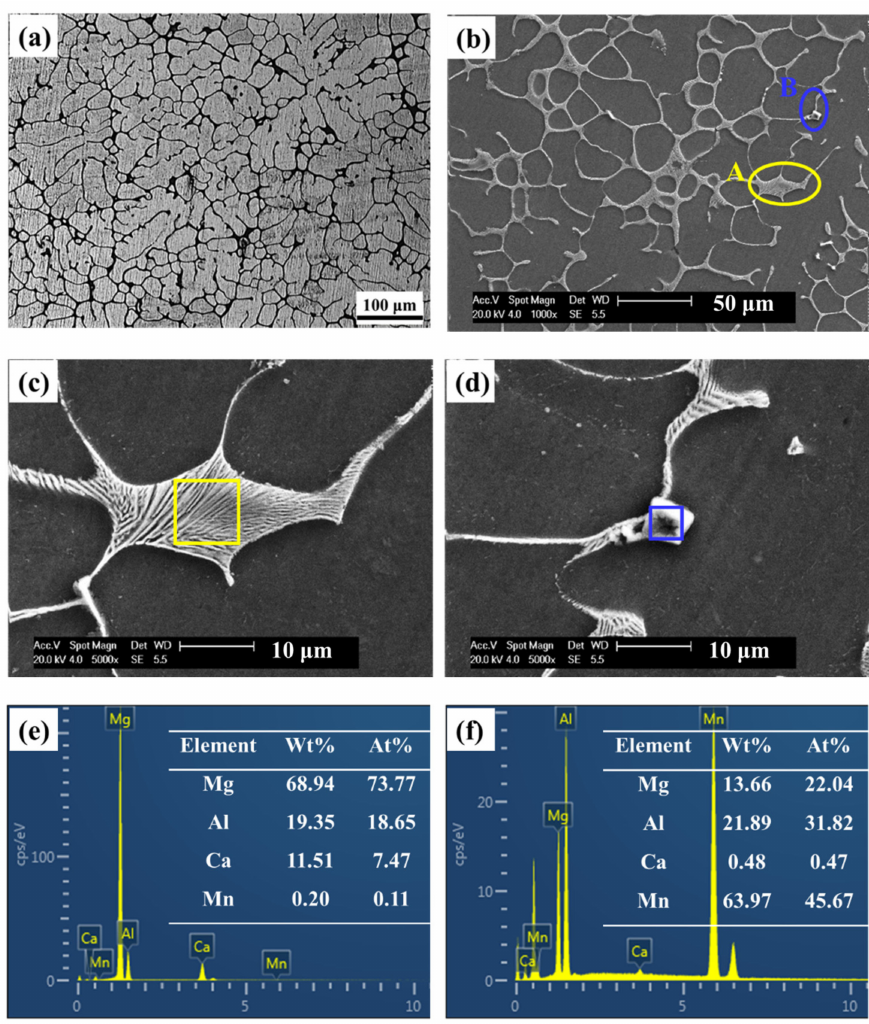
Figure 2. Microstructure of the as-cast alloy. ( a ) Optical image; ( b , c , d ) scanning electron microscope (SEM) images and enlargements of ( c ) the eutectic structure and ( d ) cubic particle; The corresponding EDS results of ( e ) the eutectic and ( f ) the particle.